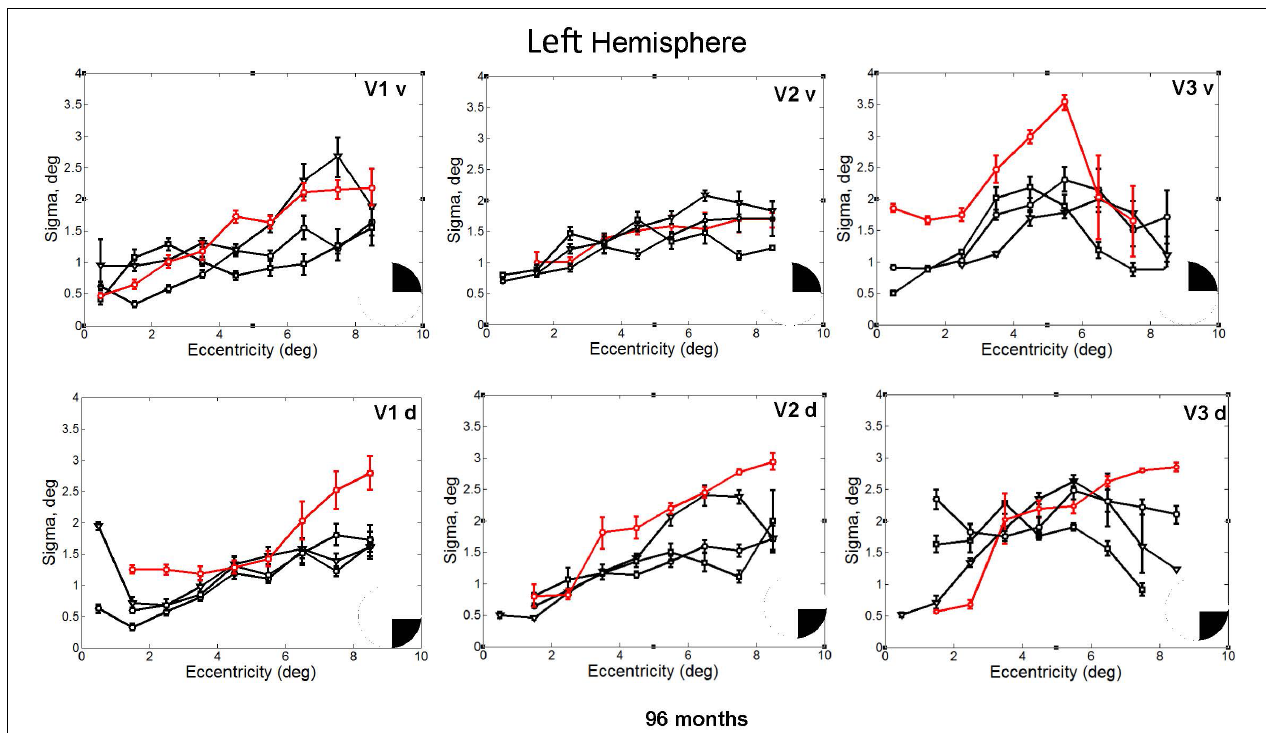
FIGURE 5 | pRF size ( σ ) plotted against eccentricity for the ventral and dorsal early visual areas. Red color corresponds to CW, black color, to the three controls. Symbols denote the mean in each eccentricity band. Error bars denote 1 standard error of the mean. The black triangle in the circle represents the visual field quadrant that each visual area corresponds to the most recent perimetry tests (at 96 months, see also Figure 1 ) demonstrate that CW’s vision remained intact only within a wedge-shaped region in the upper right visual quadrant (thus corresponding to ventral visual